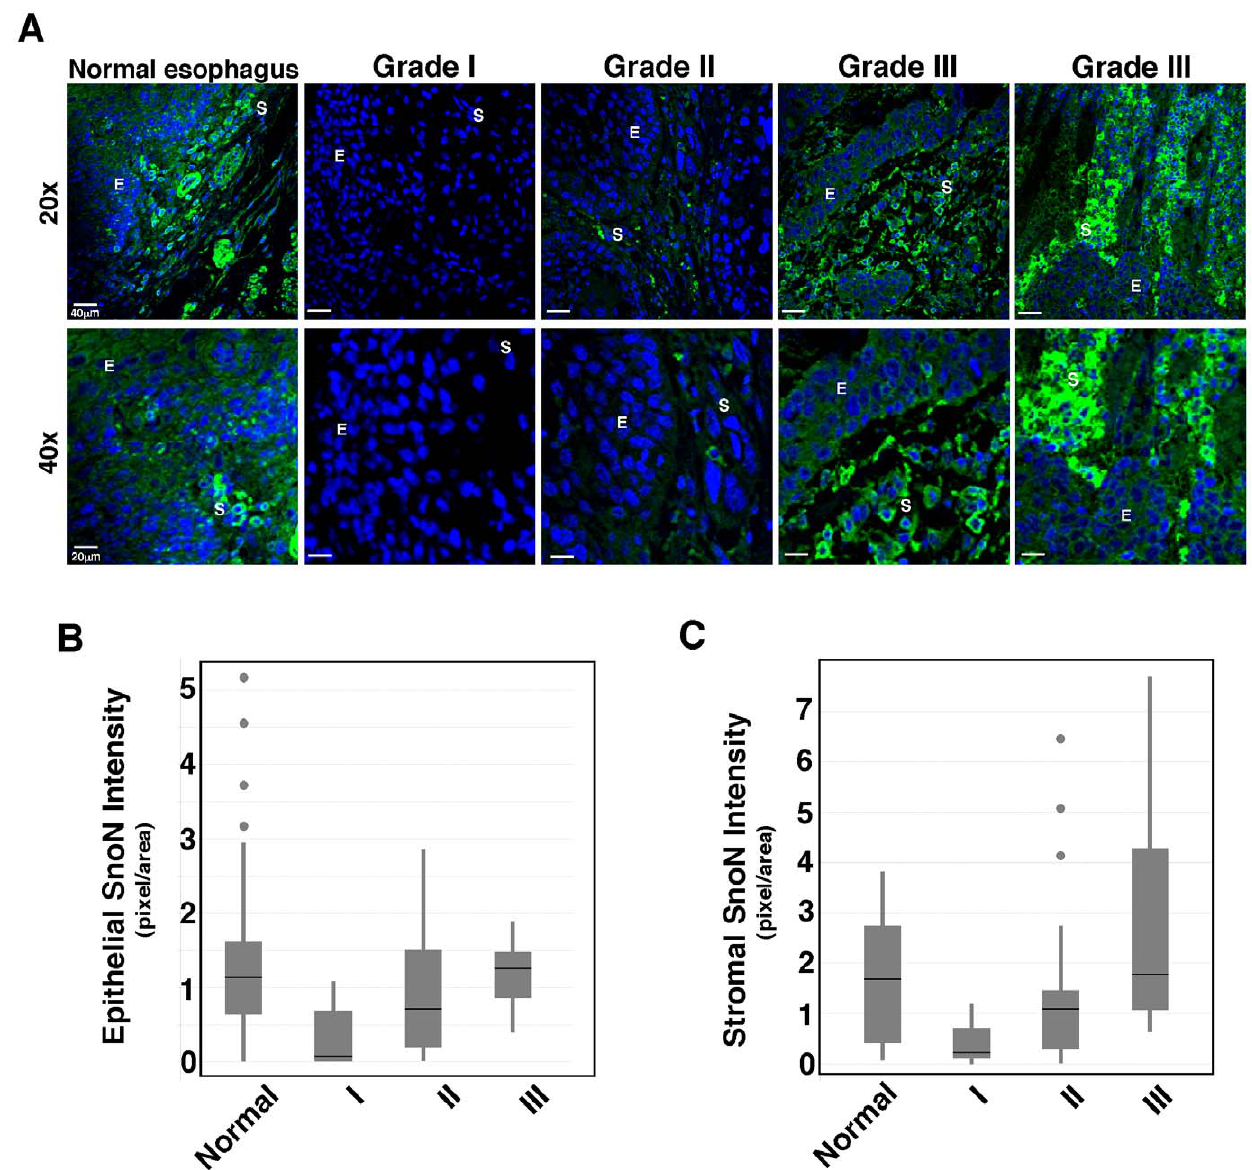
Figure 2. SnoN expression in esophageal adenocarcinoma. A, Representative SnoN staining of esophageal cancer of various grades at 20X (top) or 40X (bottom) magnifications. Two grade III samples representing different levels of SnoN expression were shown. E: epithelium; S: stroma. Green: SnoN; blue, DAPI. B, SnoN staining in normal and tumor epithelial cells was quantified using the Image J software and the numbers were plotted in the box plot, which includes normal samples (n=36, mean intensity=1.13) and esophageal tumor samples of grade I (n=8, mean=0.07), II (n=19, mean=0.71), and III (n=11, mean=1.26). Statistical analysis comparing the normal controls to each tumor grade showed that the epithelial SnoN levels in esophageal adenocarcinoma are significantly weaker (grade I: p=0.0002) or similar (grade II: p=0.1425 and grade III: p=0.3349) to that in the control normal samples. The increase in epithelial SnoN expression in grade III compared to grade I was statistically significant (p=0.0013) . C, Quantification of SnoN stromal staining in normal samples (n=27, mean=1.69) and esophageal tumor samples of grade I (n=5, mean=0.23), II (n=19, mean=1.09), and III (n=11, mean=1.78). The statistical analysis comparing the normal controls to each esophageal tumor grade is as follow: p=0.0023 for grade I, p=0.8565 for II, and p=0.1132 for grade III. The increase in stromal SnoN expression in grade II (p=0.0287) and grade III (p=0.0068) tumors compared to grade I tumor stroma was statistically significant.